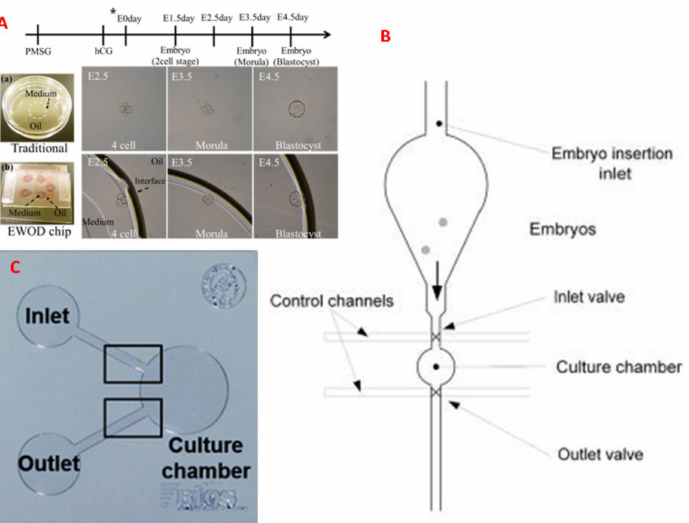
Figure 4. Different microfluidic device configurations for mouse embryo culture. ( A ) is adapted from ref. [89] with permission from PLoS ONE, ( B ) is adapted from ref. [91] with permission from John Wiley and Sons, and ( C ) is adapted from ref. [92] with permission from the Royal Society of